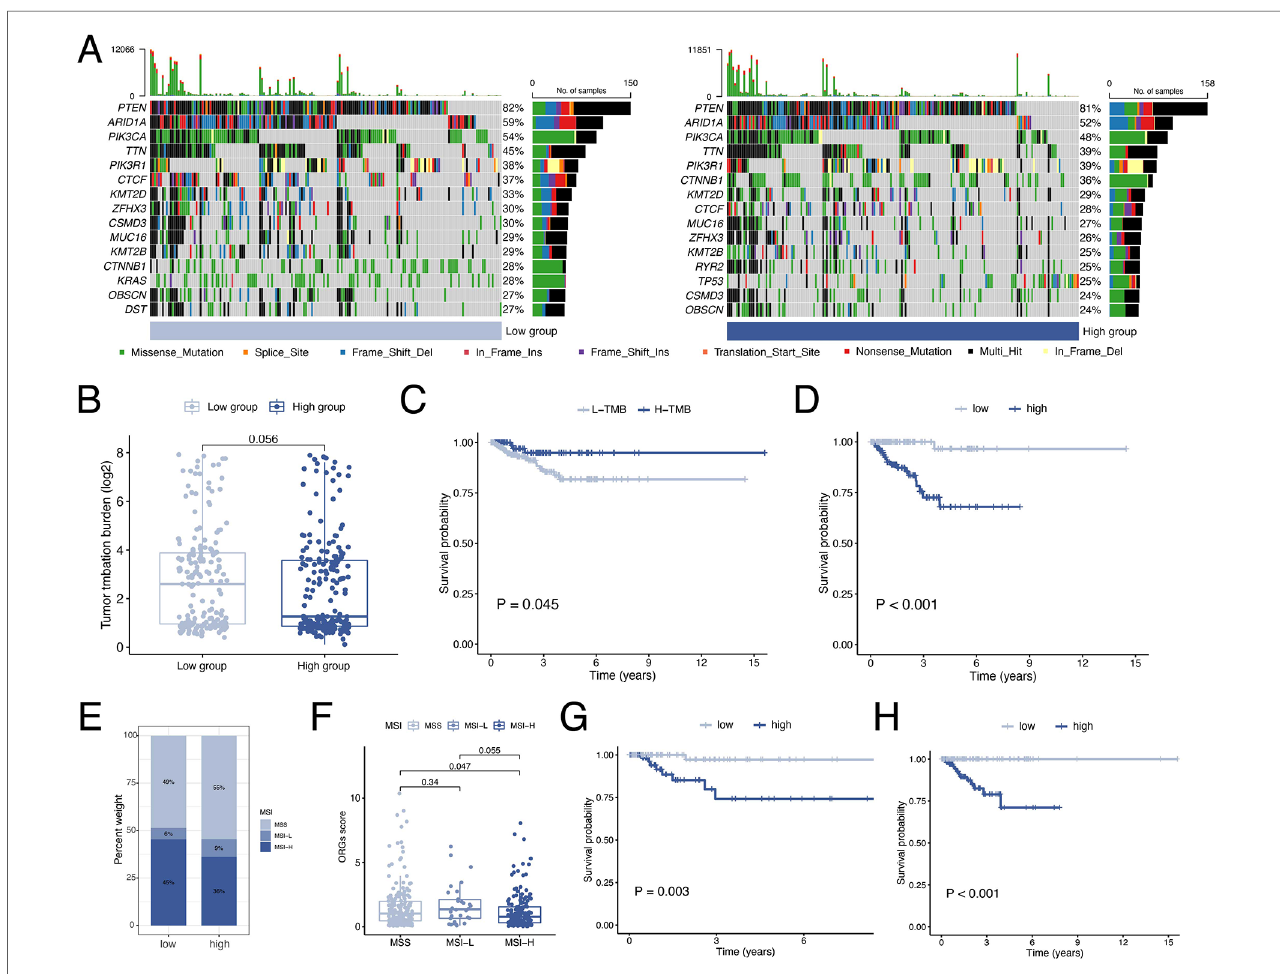
FIGURE 8 Analyses of mutation data. ( A ) Visualization of somatic mutations in different ORGs groups. ( B ) Differential analysis of TMB in ORGs scoring groups. ( C ) Kaplan – Meier curves of survival differences between the high- and low-TMB groups. ( D ) Kaplan – Meier curves of survival differences between ORGs scoring groups in low-TMB patients. ( E ) Distribution of MSI status in the different scoring groups. ( F ) Differential analysis of the ORGs score in patients with different MSI status. Kaplan – Meier curves of survival differences between ORGs scoring groups in patients with MSI-H ( G ) and MSS ( H ). ORGs, obesity-related genes. TMB, tumor mutation burden. MSI, microsatellite instability. MSI-H, high microsatellite instability. MSS, microsatellite